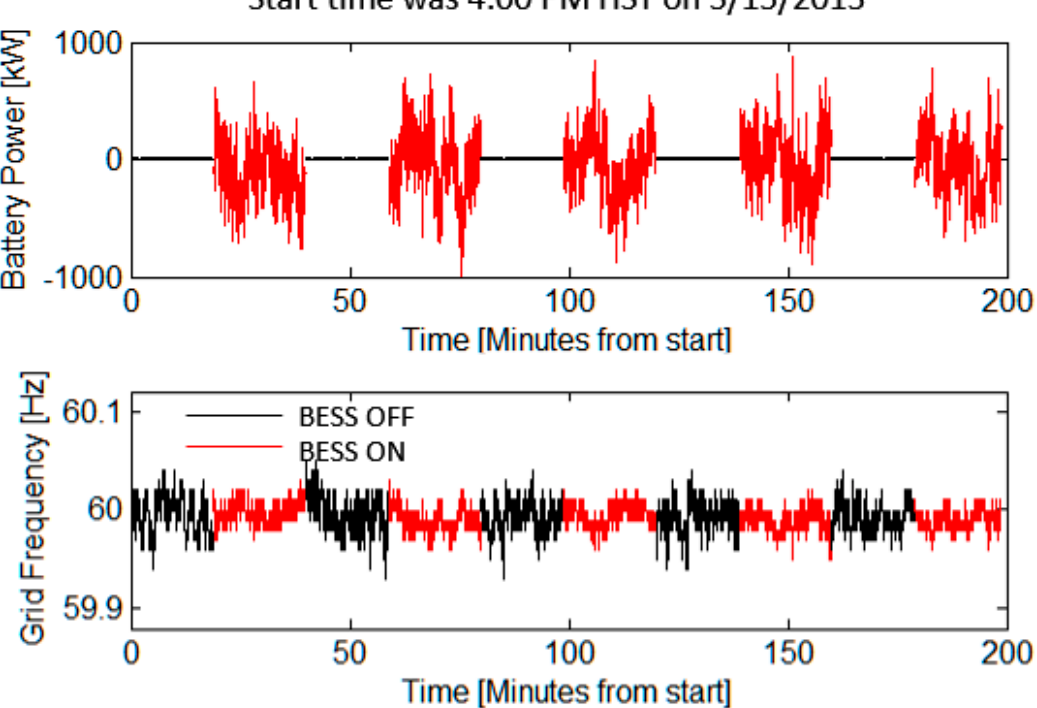
Figure 3. BESS power ( top ) and frequency ( bottom ) from representative 200-min experiment conducted on 15 March 2013. BESS parameters: gain = 30 MW/Hz, and deadband = 0 Hz. The results shown here were from an early experiment. In subsequent experiments, when we tried to isolate the frequency variability to wind generation (not solar), the start time was 6 pm.